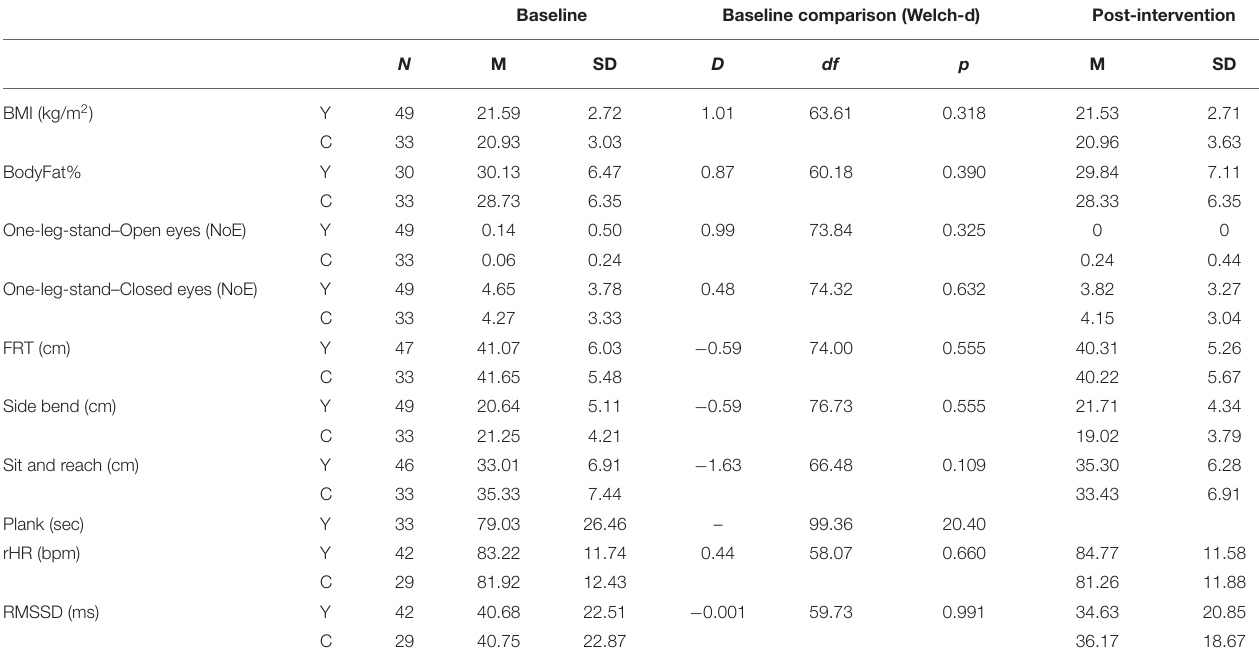
TABLE 1 | Descriptive data of the assessed variables before and after the intervention, and baseline comparison of the groups. Baseline Baseline comparison (Welch-d)